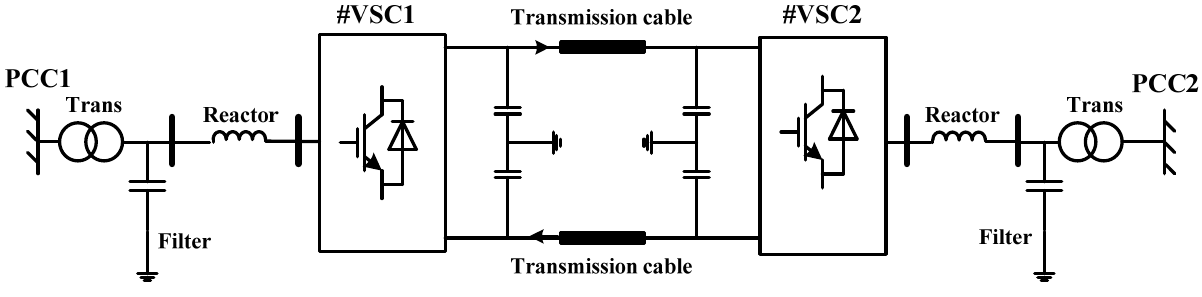
Figure 1. Configuration of voltage-source converter-high voltage direct current (VSC-HVDC)